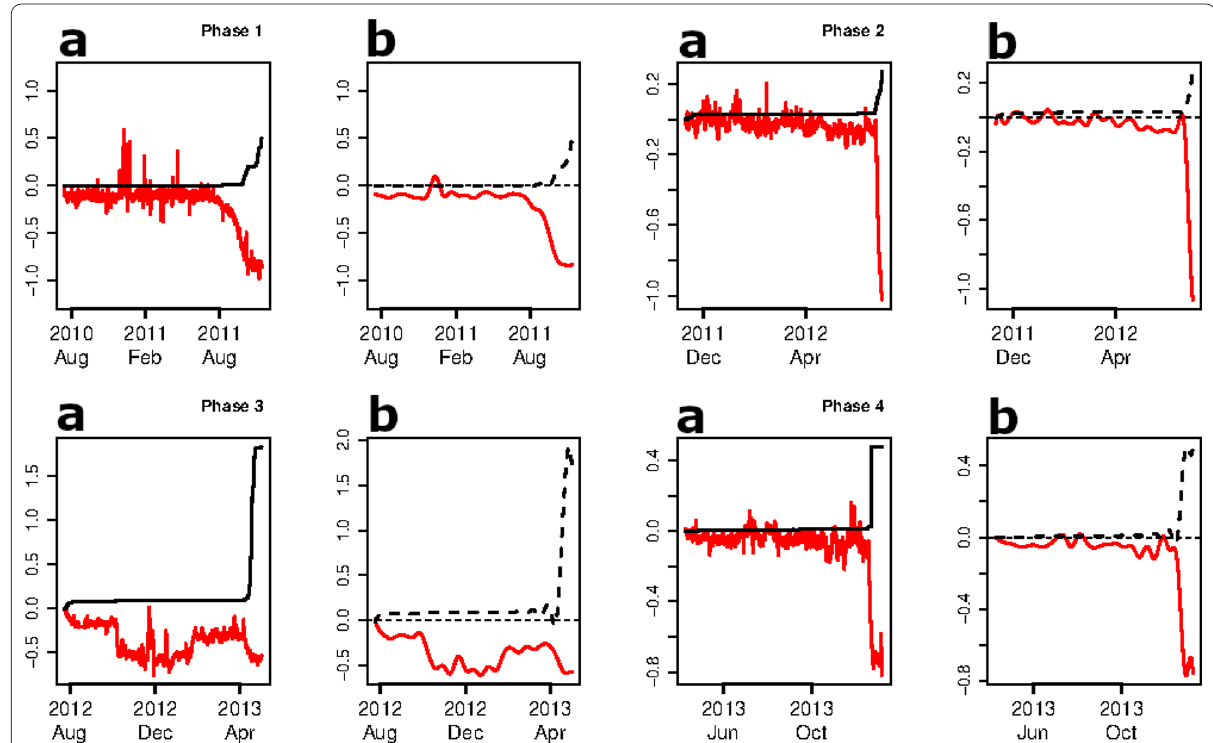
Fig. 9 Standardized displacement‑data series and the standardized data series about the cumulative energy released data by phases (Figures a ) and the same data in the p‑splines basis with the optimal parameters (Figures b )